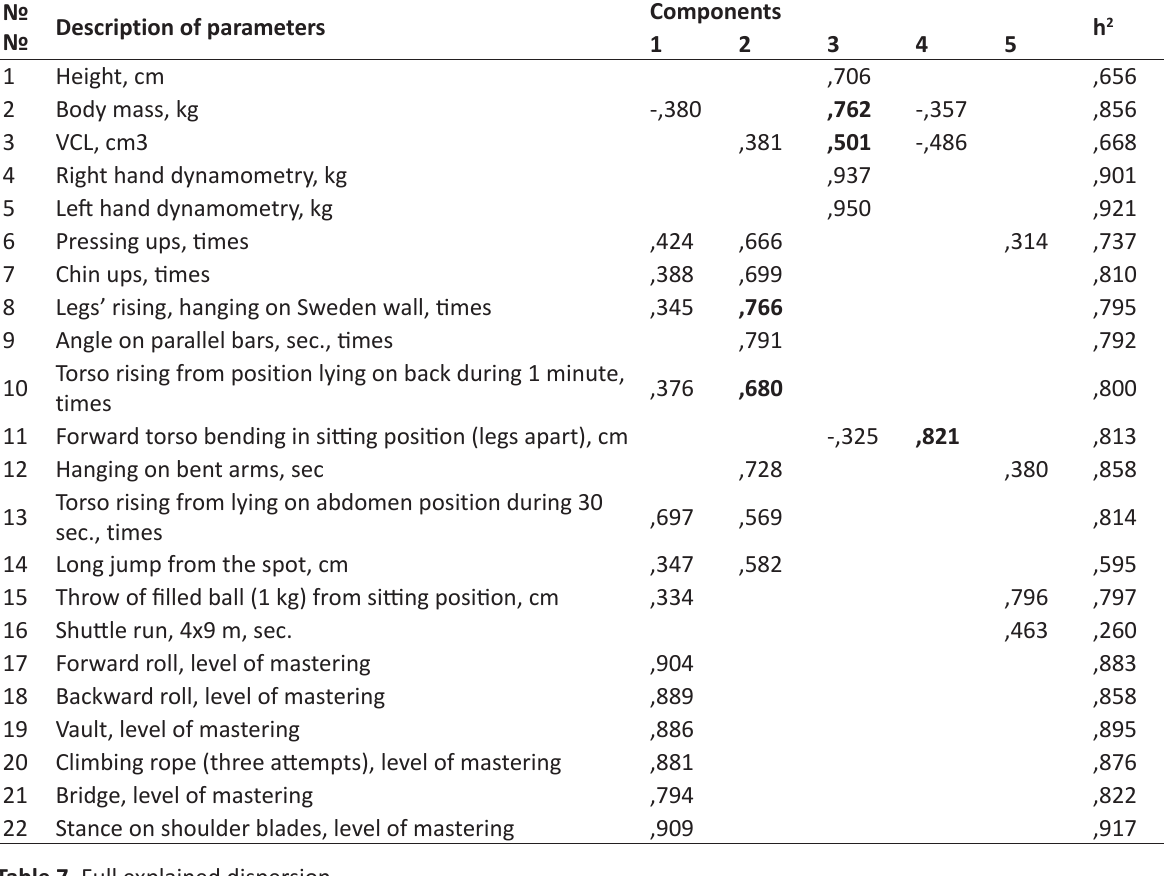
Table 6. Matrix of actorial analysis of 13 yrs boys’ testing. Rotation method: Varimax with Kwiser’s normalization № Description of parameters №